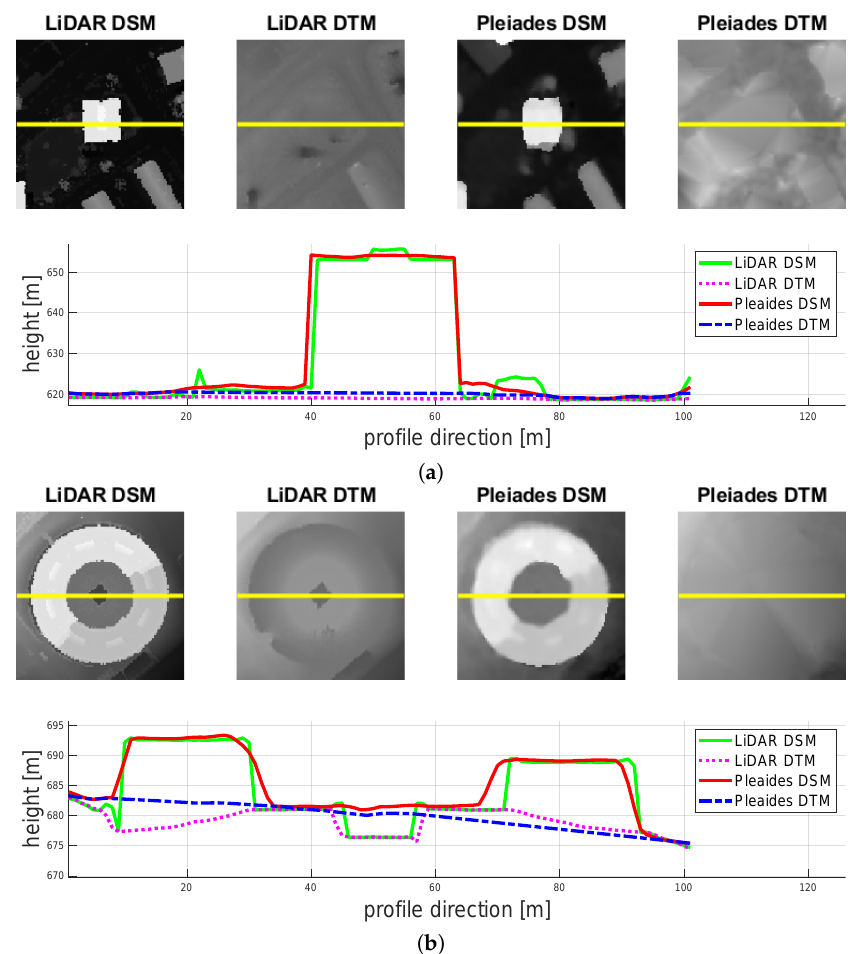
Figure 29. Profile comparisons of DSMs and DTMs from LiDAR and Pléiades for two small scenes, representing ( a ) a skyscraper and ( b ) a round